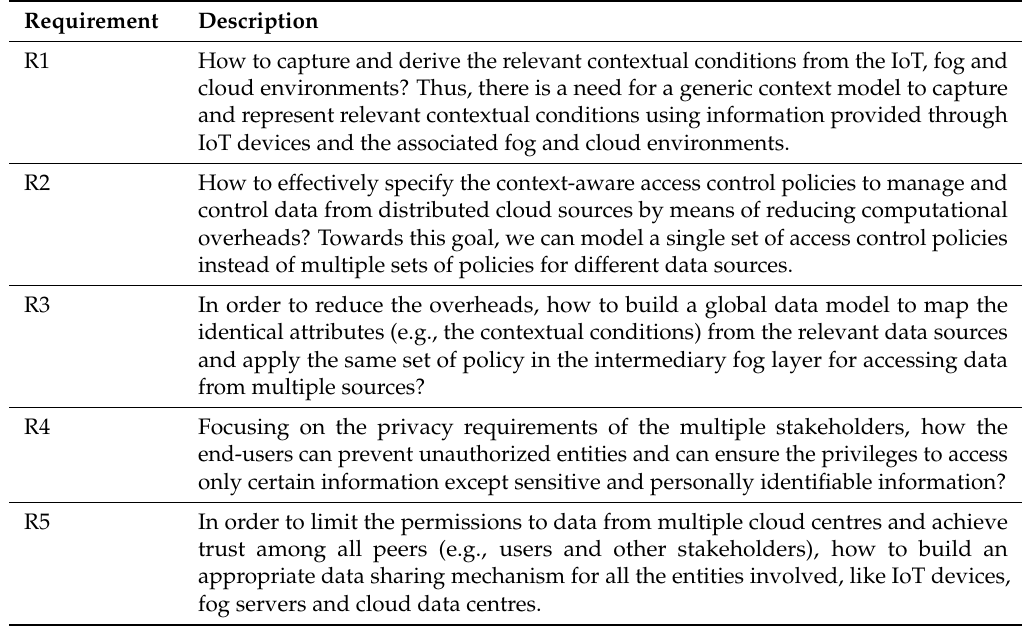
Table 6. The general requirements of fog-based CAAC